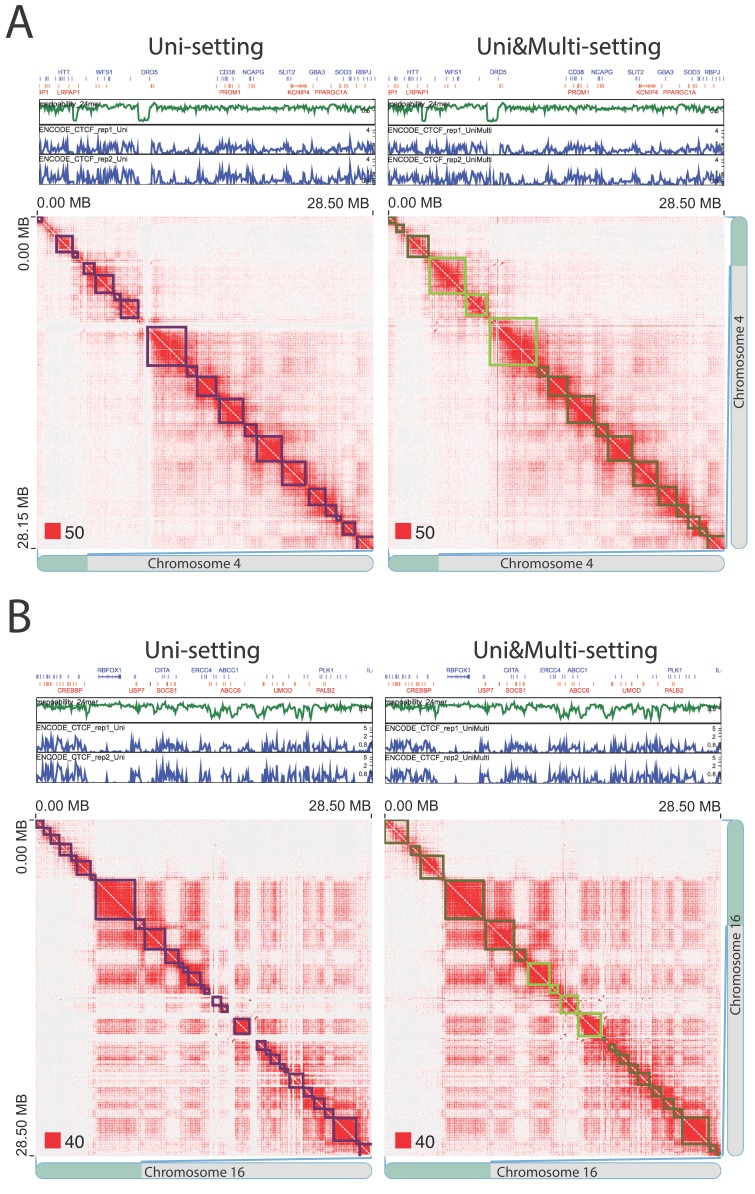
False positive topologically associating domains (TADs) detected by the Uni-setting due to the missing reads in low mappability regions (IMR90).TADs that are split by white gaps are no longer detected once multi-reads are incorporated, indicating that they are highly likely false positives under the Uni-setting. (A) Example on chr4:0–28,500,000. (B) Example on chr16:0–28,500,000. Red squares at the left bottom of the matrices indicate the color scale.